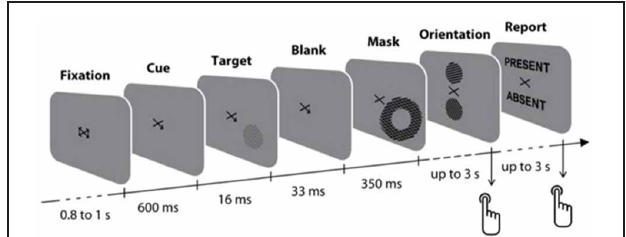
FIGURE 1 | Experimental design. At the beginning of each trial, participants were cued by a predictive central arrow to covertly attend either to their left or right lower visual field. After 600ms, a target grating at detection threshold was briefly presented for 17ms either at the cued or miscued location, or occasionally was not presented at all, and was followed after 50ms by a high-contrast metacontrast mask, surrounding without overlapping the target location. Four-hundred milliseconds after target onset, participants first selected the perceived orientation of the target grating among two choices (discrimination task), and then reported whether they had detected the presence of a target before the mask (detection